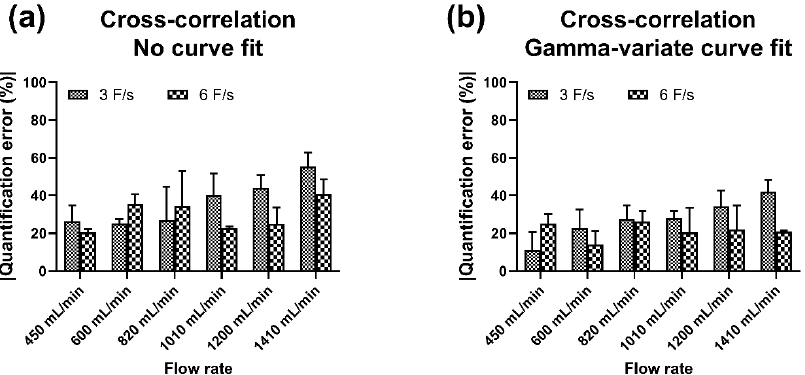
Figure 5. Evaluation of quantification accuracy of CC algorithm at different flow rates for DSA acquisition. Absolute quantification error ( a ) without curve fit, and ( b ) with GV curve fit. The bias, limits of agreement (LOA), and 95% confidence interval (CI) of the mean quantification error for the DSA acquisition and fluoroscopic imaging were assessed (Table 1). Bias and LOA were calculated based on Bland-Altman’s theory [50]. Bias indicates the systemic tendency of the method to under- or overestimate the actual measurement and calculated as the mean of the measured differences with in-line flow sensor measurement. LOA indicates agreement of the calculated value with the measured (actual) value and depicted by a bandwidth (bias ± 1.96 × SD of differences), where 95% of the differences are expected to lie (the narrower the bandwidth, the more precise is the measurement). Since the CC algorithm had the least quantification error, we have shown BA analyses for this method (DSA acquisition: Figure 6, Fluoroscopy: Figure S3). The CC algorithm with GV curve-fitting had the best agreement with the measured values. The 95% CI for the bias and LOA bandwidth was also the least indicating reproducibility (precision/ repeatability) of the measurements. The CC algorithm with GV fit at 6 F/s exhibited a good correlation with the actual flow ( r = 0.898). We made similar observations for fluoroscopic imaging, except that the range was wider, which indicated large variabilities of measurements over DSA acquisition. The correlation ( r ) between measured flow rates obtained with CC algorithm + GV fit at 10 P/s and in-line flow sensor was 0.334. Table 1. Summarized key statistical parameters for PP and CC algorithms with/without curve fitting.